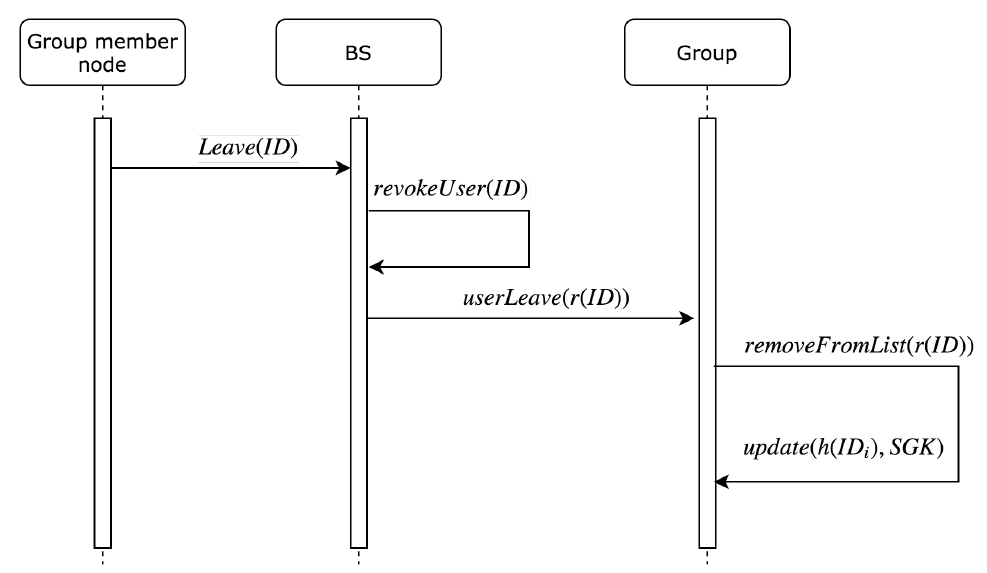
Figure 5. Sequence diagram for leaving node